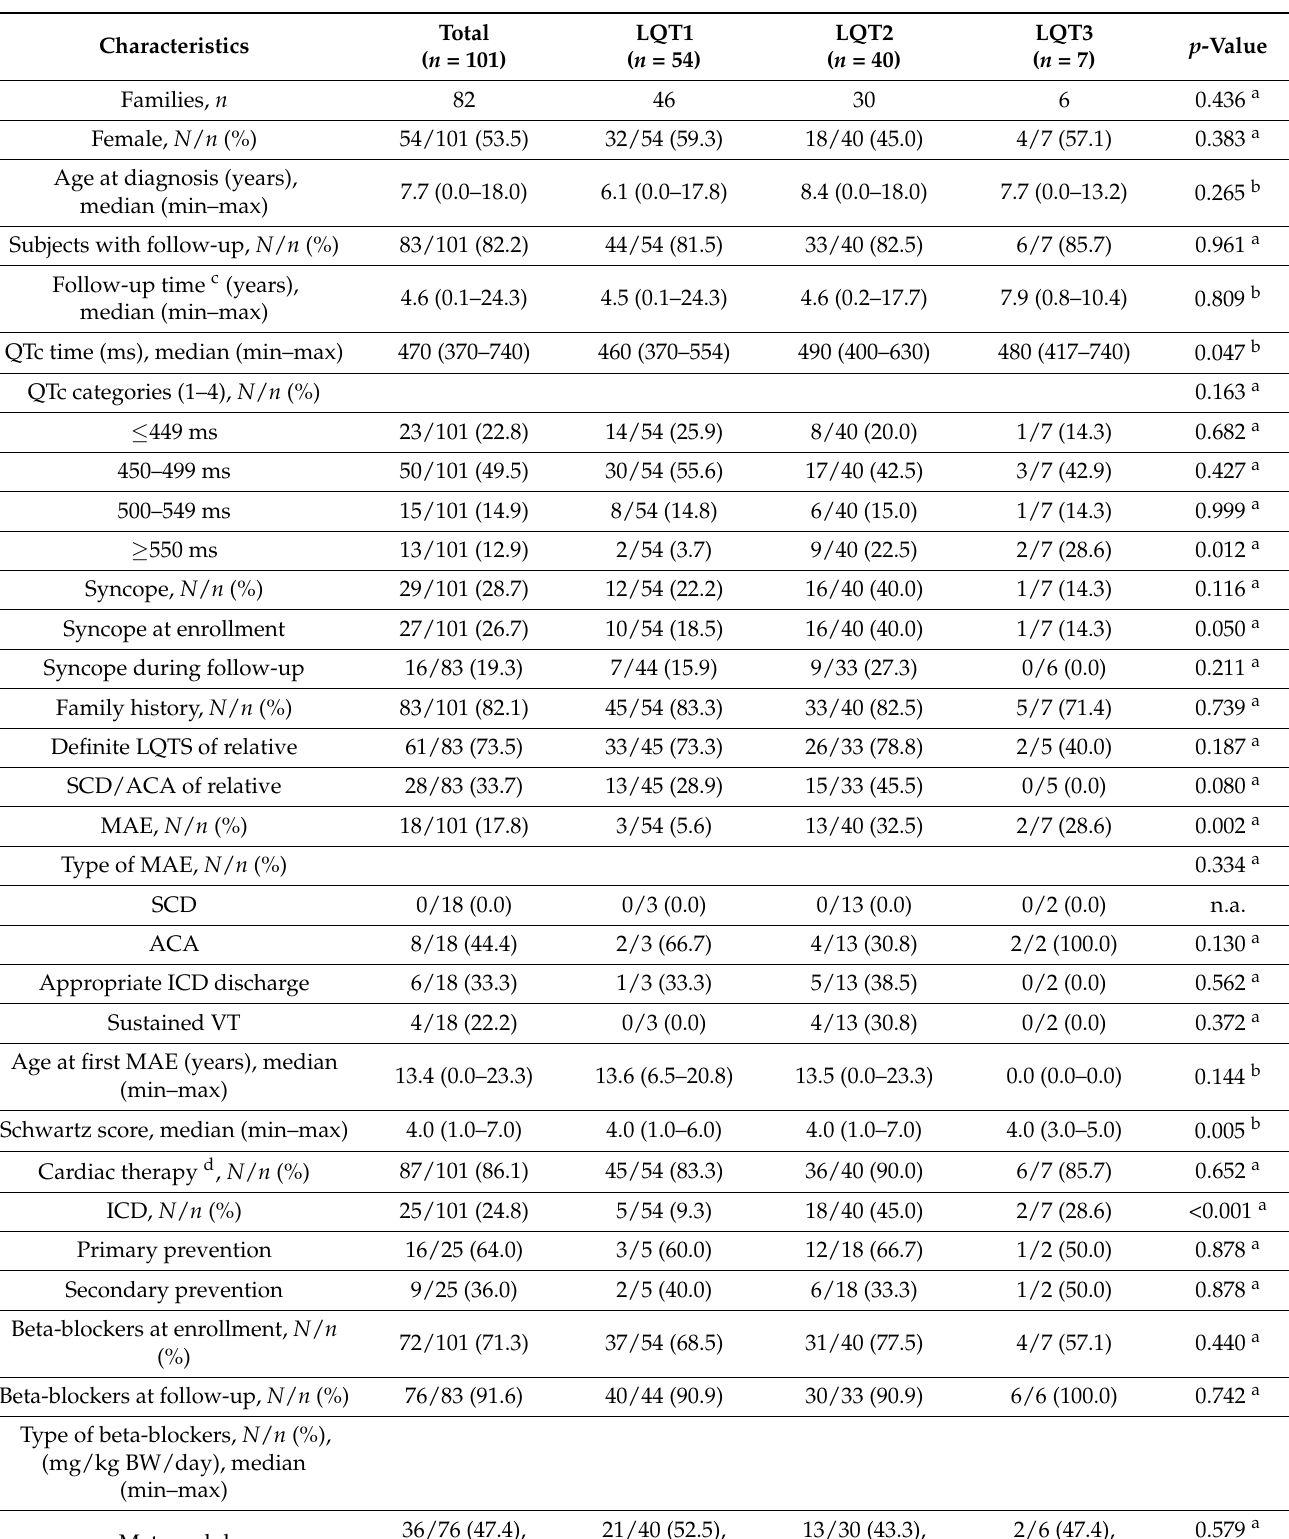
Table 1. Patient characteristics with clinical and genetic findings by